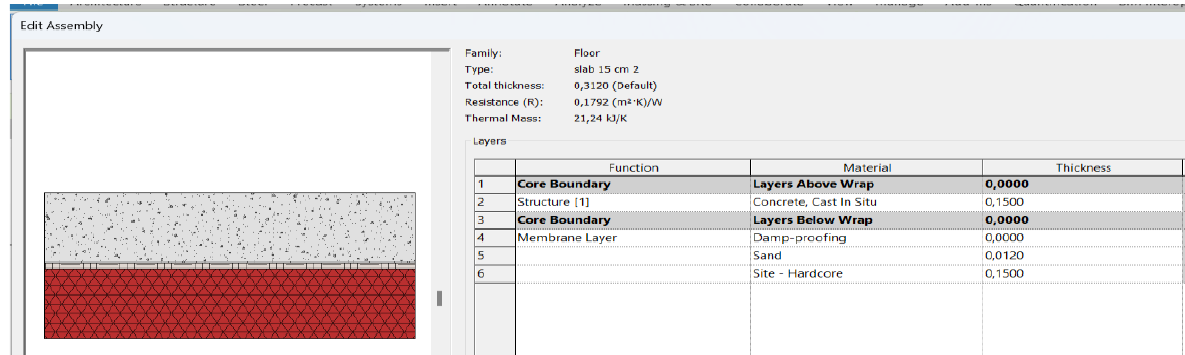
Figure A2. Wall energy analytical properties (Case 1).